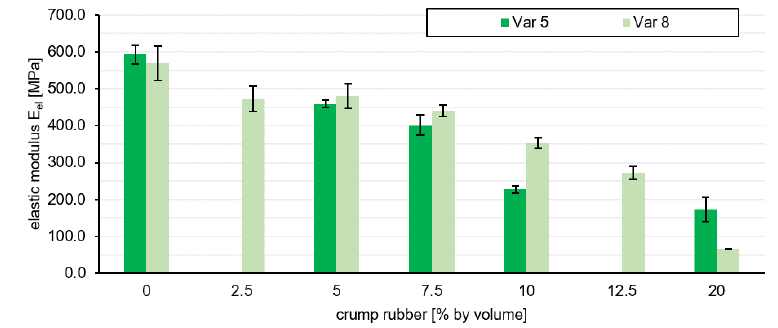
Figure 6. Evaluation of the elastic modulus of all tested